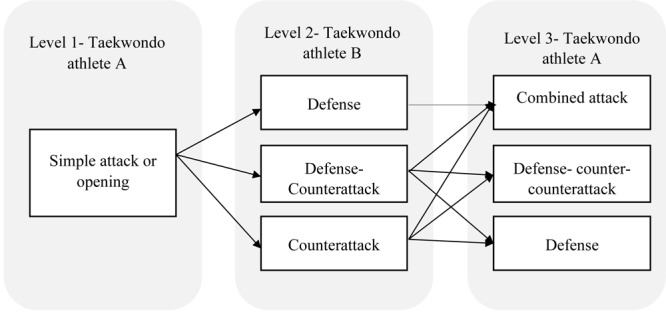
Offensive-defensive tactical schema in taekwondo (Menescardi, 2017).